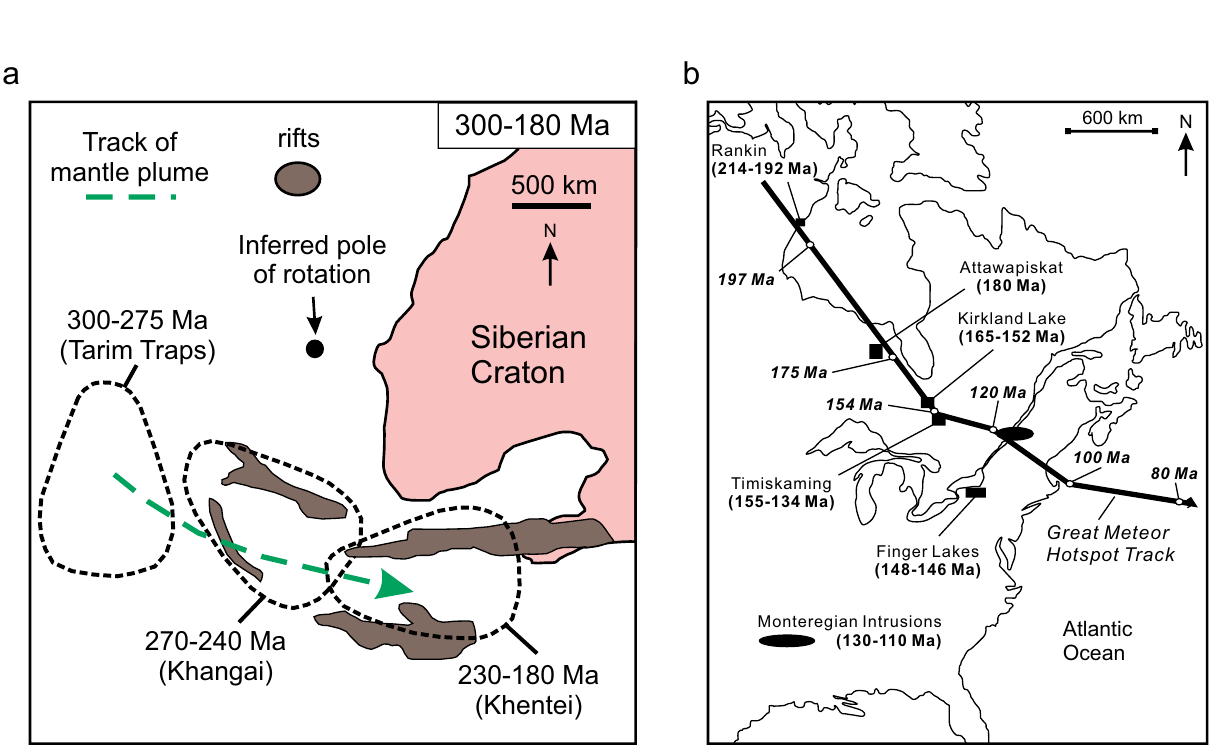
Figure 5. ( a ) The proposed Mongolia mantle plume track of Central Asia 101 . ( b ) The distribution of magmatic rocks correlated to the Great Meteor hotspot track and the position of North America 100